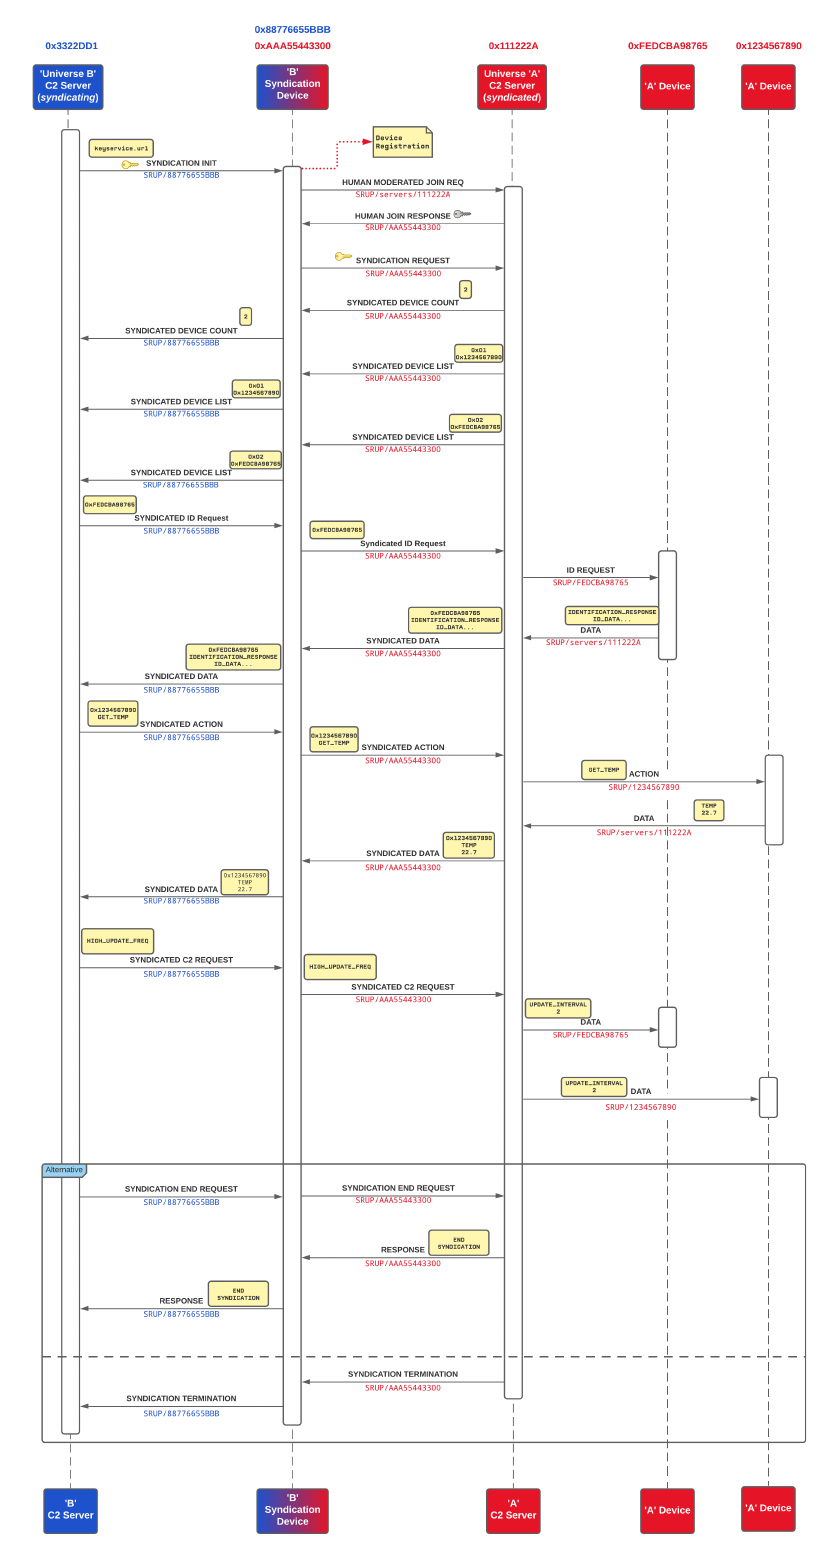
Figure 4. A sequence diagram showing an example data exchange between the devices described in Section 5.1, during SRUP syndication operations. The text beneath the message-type line denotes the MQTT topic used by SRUP to carry the message, as specified within the SRUP